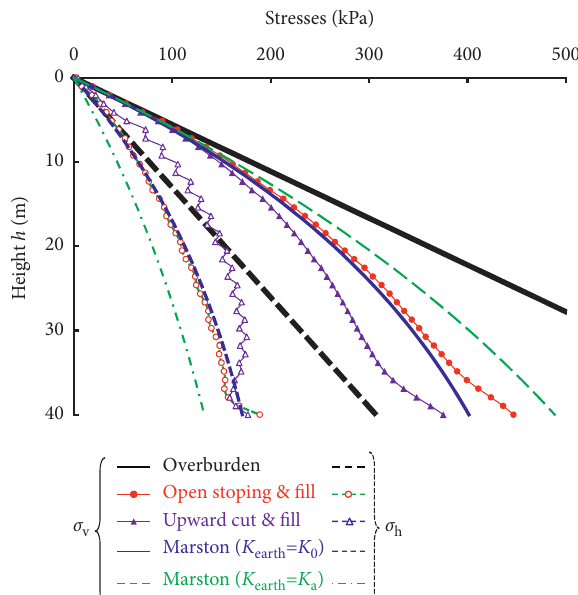
Figure 7: Comparisons of vertical ( σ v ) and horizontal ( σ h ) stresses plotted along VCL of simulated stopes in two mining methods with analytical results of the Marston